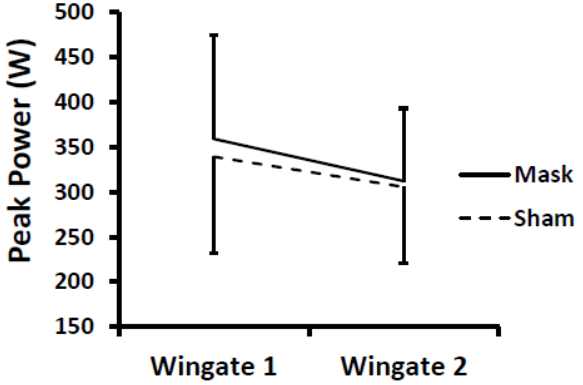
Figure 4. Change in peak power during repeated Wingate tests for mask and sham conditions. There were no differences between conditions. There was a time main effect ( p < 0.001) with Wingate 2 < Wingate 1. Values are means and error bars are SD. Table 1. Work rate during simulated hockey period in